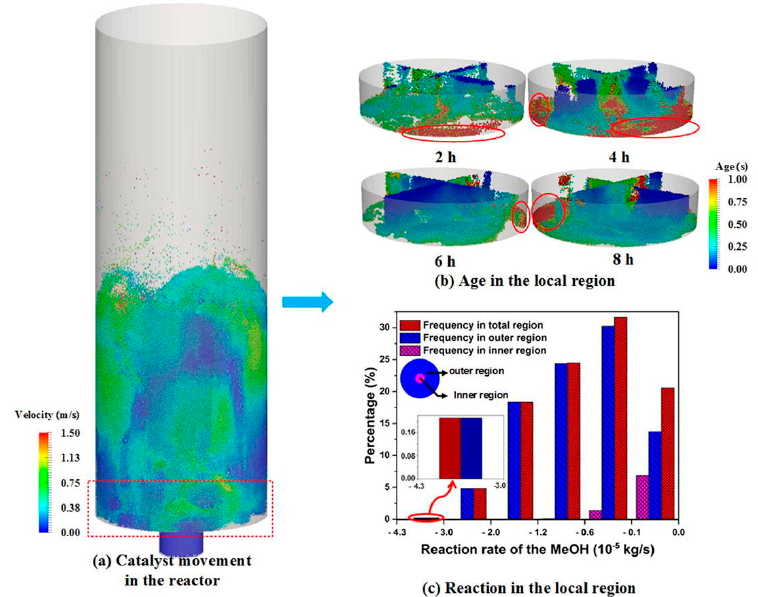
Figure 10. Simulation of the methanol-to-olefin (MTO) process in a bubbling fluidized bed for 8 h of simulated time, with details on the solids flow ( a ), age ( b ) and methanol reaction rate ( c ). Reprinted from [98], with permission from Elsevier.